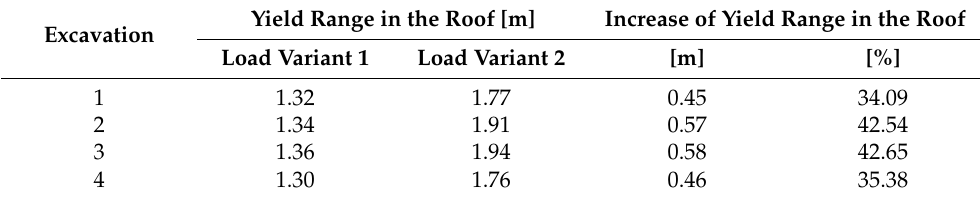
Table 6. List of the yielded rock mass range in the roofs of the analyzed headings (yield between 50% and 100%).